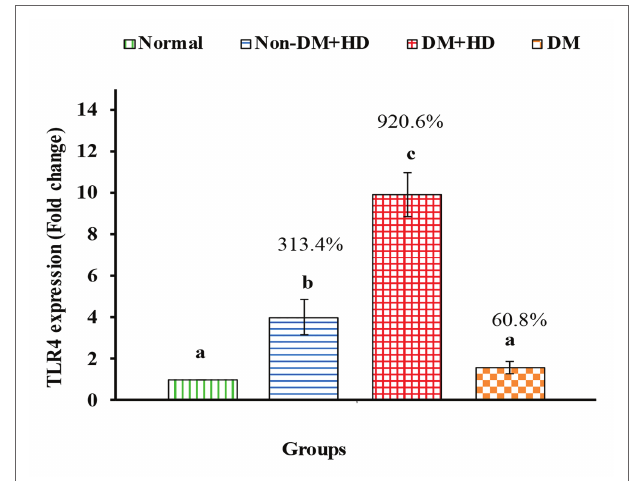
FIGURE 3 | The level of interleukin 6 [IL-6 (pg/mL)] in the blood of non-diabetic and diabetic patients with or without kidney failure. Means, which have different superscript letters, are significantly different at p < 0.05. Percentage changes were calculated in comparison with normal group. Value of p : 0.001.